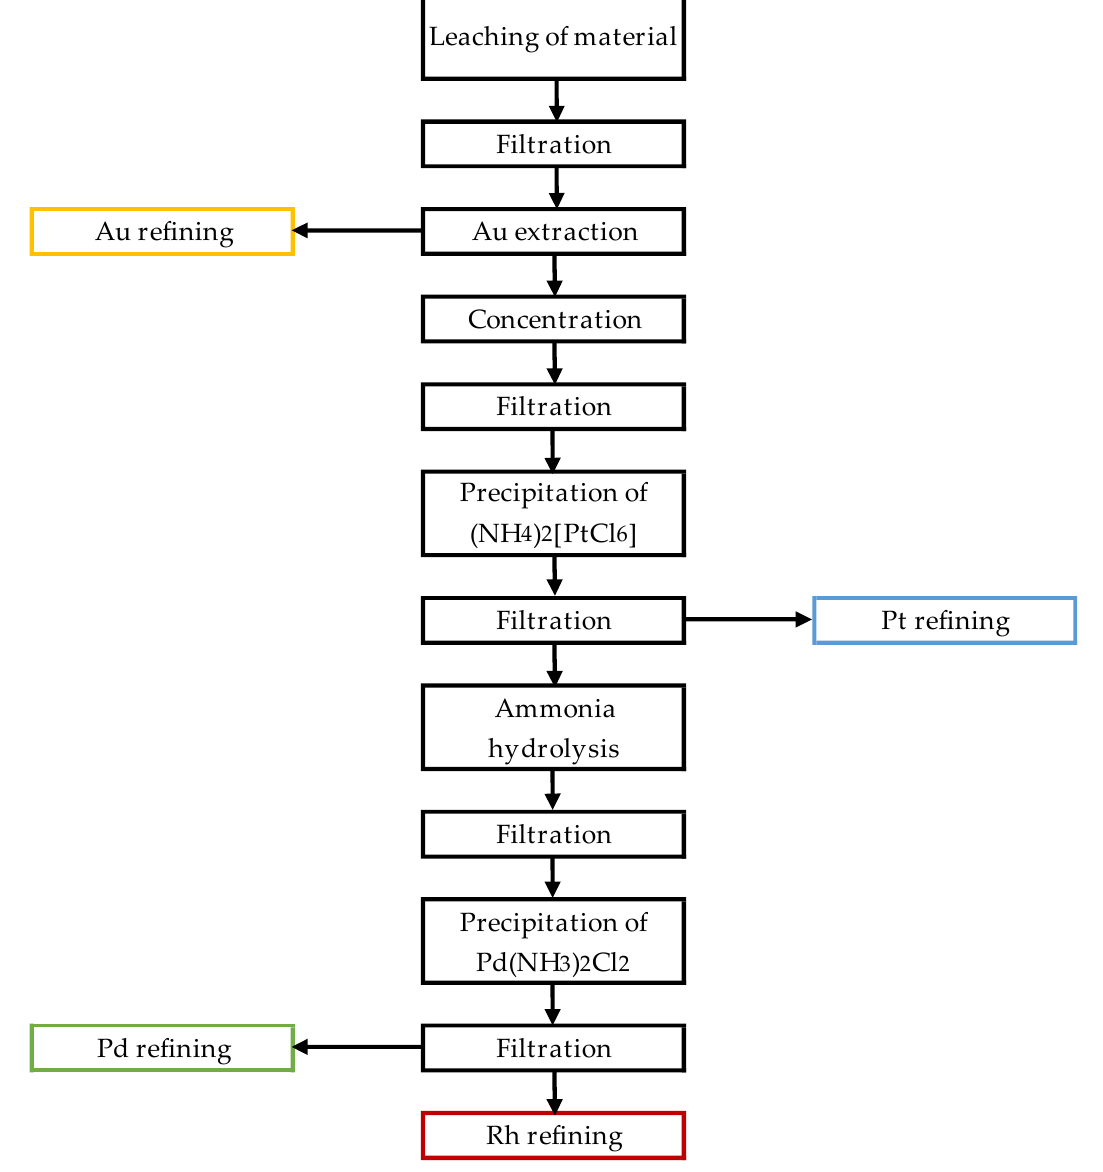
Figure 1. Simplified scheme of the noble metal refining process conducted in the Łukasiewicz Research Network-Institute of Non-Ferrous Metals.